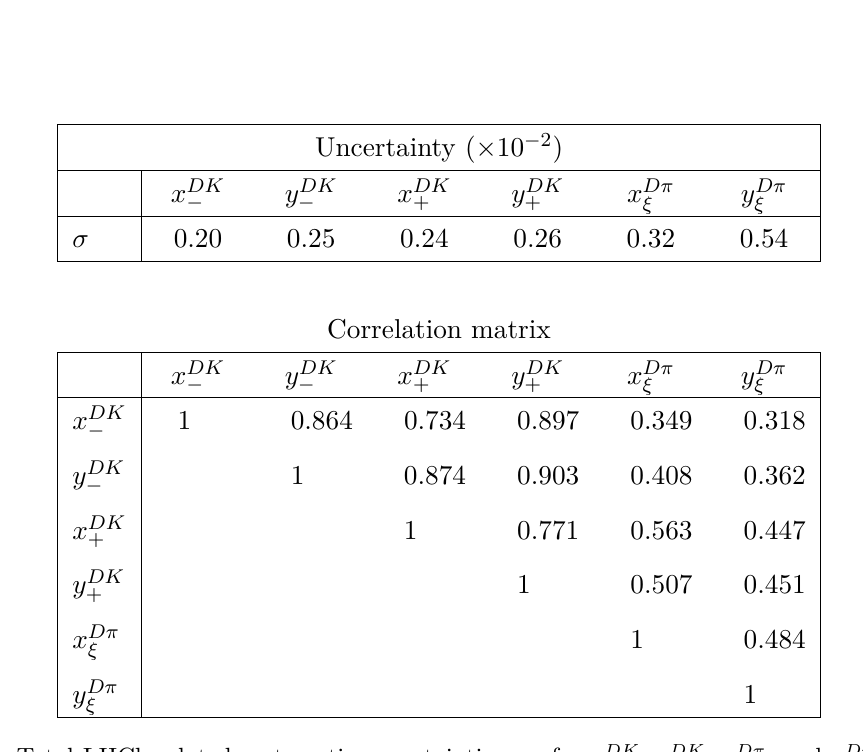
Table 4 . Total LHCb-related systematic uncertainties, σ , for x DK corresponding correlation